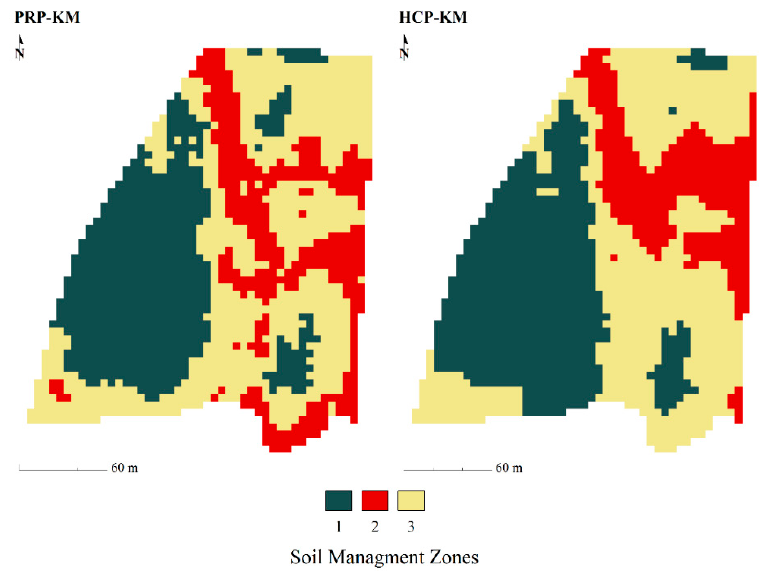
Figure 6. Precision soil management zones (1–3) within the agroforestry site in Fayetteville, AR that were generated by the k-means (KM) clustering algorithm using all 12, perpendicular (PRP) and horizontal coplanar geometry (HCP) apparent electrical conductivity surveys. Maps were created in R Studio (version 4.05, R Core Team, Boston, MA, USA). Table 4. Summary of the perpendicular (PRP) and horizontal coplanar geometry (HCP) apparent electrical conductivity (EC a ) for each cluster generated by the k-means clustering algorithm using 12 electromagnetic-induction EC a surveys conducted at an agroforestry site in Fayetteville AR be-